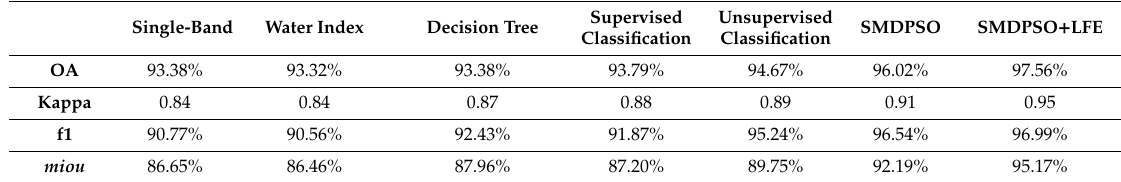
Table 3. Comparison results of the coe ffi cients of extraction using di ff erent methods.